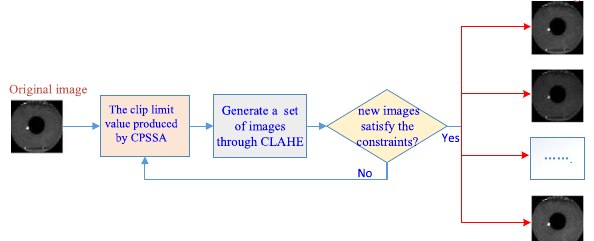
Fig. 1 Overview of the proposed method